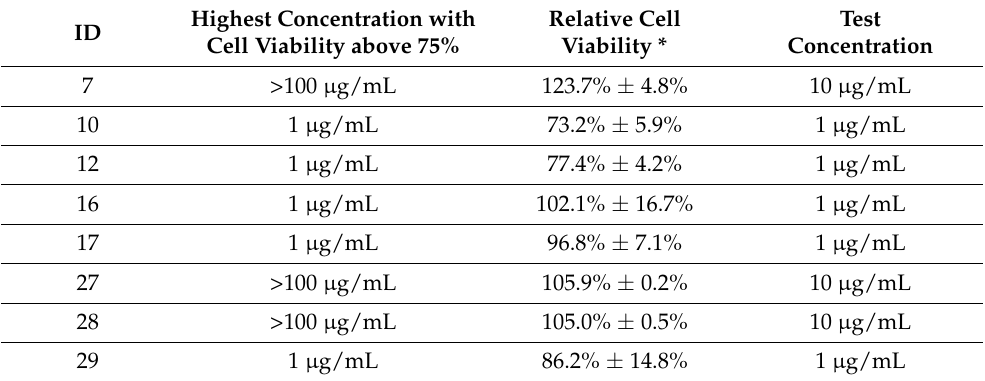
Table 3. Cell viability of tested antiherpes active compounds with African green monkey kidney cell line (VERO).